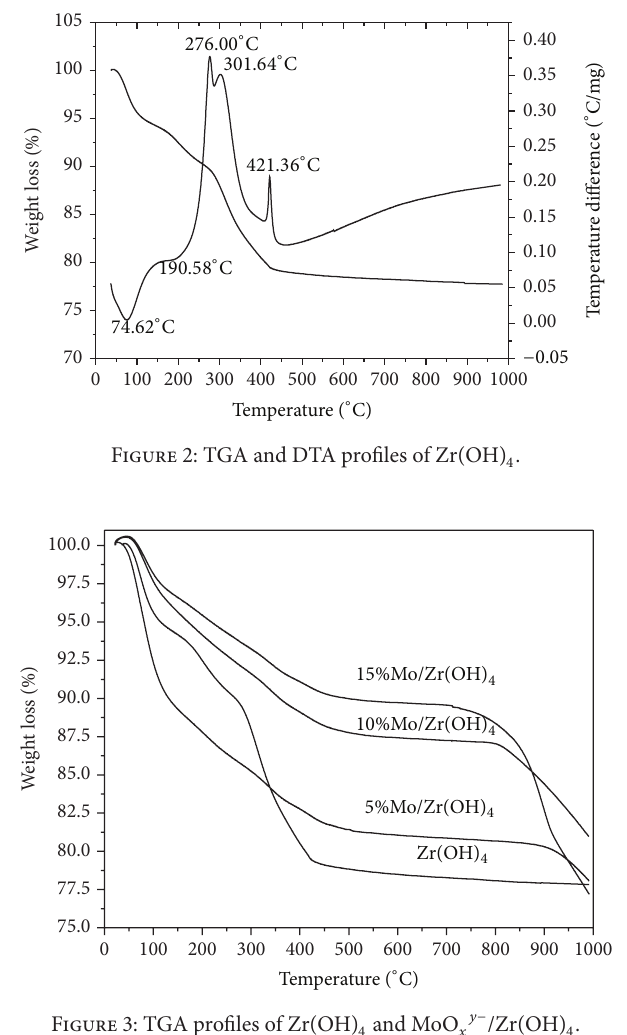
Figure 5: DTA profiles of MoO 𝑥𝑦− /Zr(OH) 4